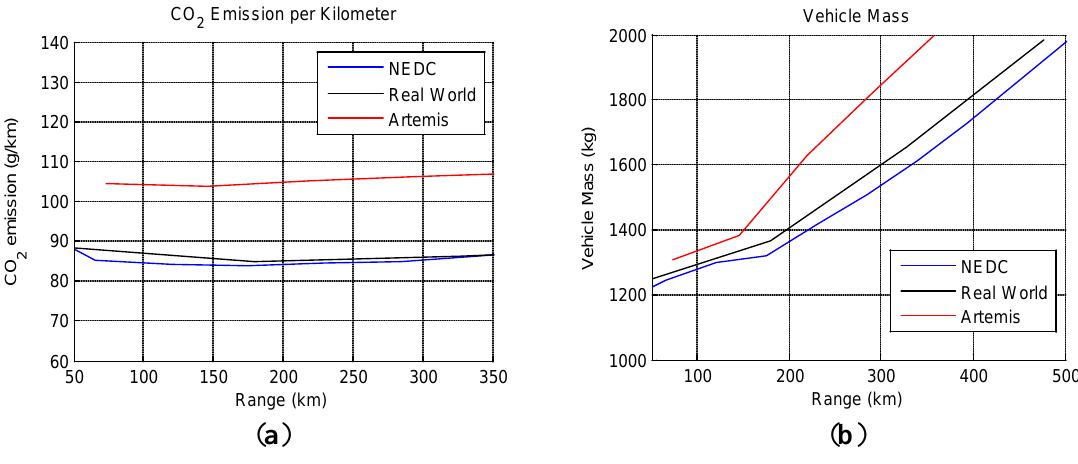
Figure 13. ( a ) CO emission per km; and ( b ) vehicle mass when optimized for lowest 2 well-to-wheel CO 2